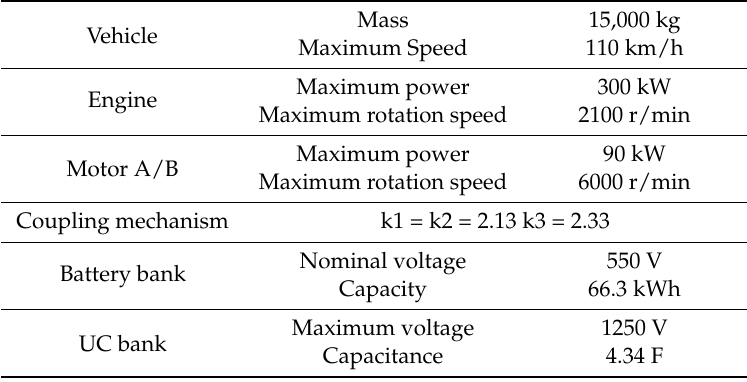
Table 4. Main parameters of the EMT vehicle.